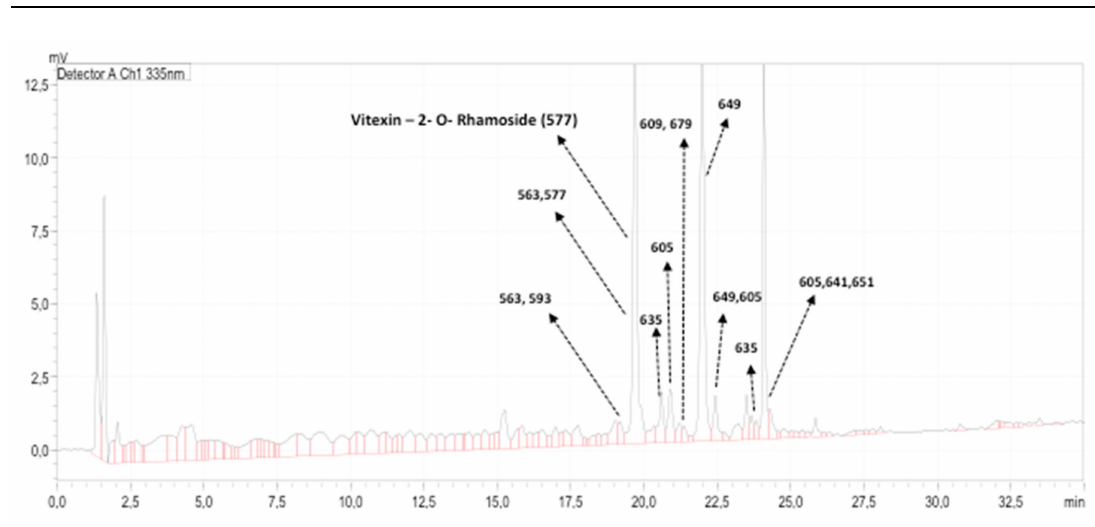
Figure 2. Ultra-high pressure liquid chromatography—tandem mass spectrometer (UHPLC-MS/MS) fingerprinting of the leaf extract obtained at 335 η m and the ions ( m / z ) of the compounds